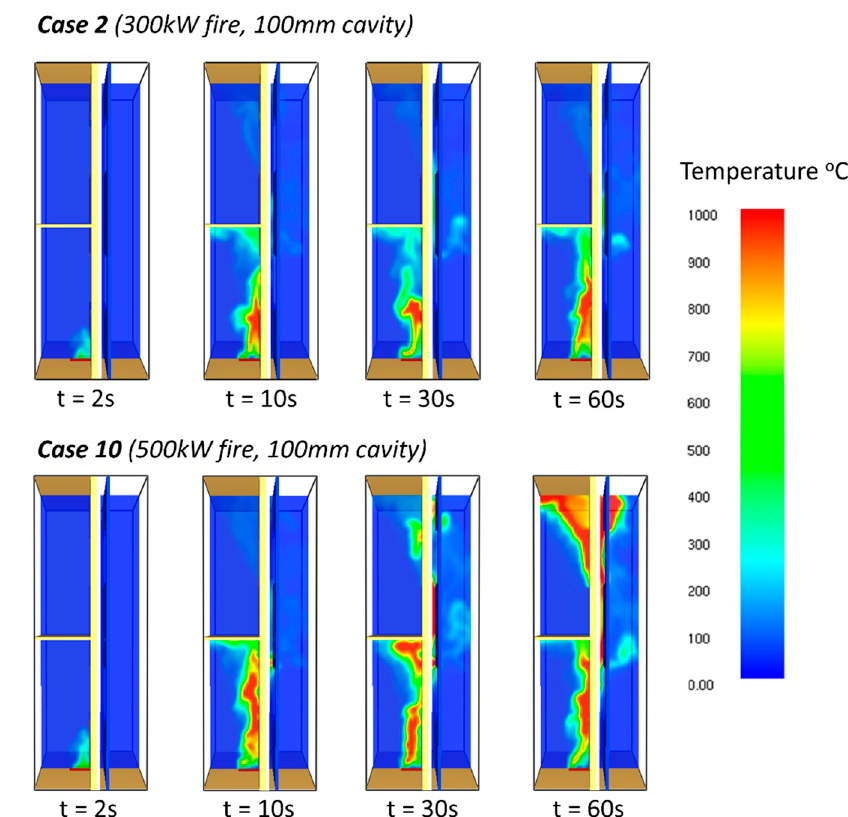
Figure 7. Temperature contour of Case 2 where there was no ignition and Case 10 where the fire spread over the entire external cladding.